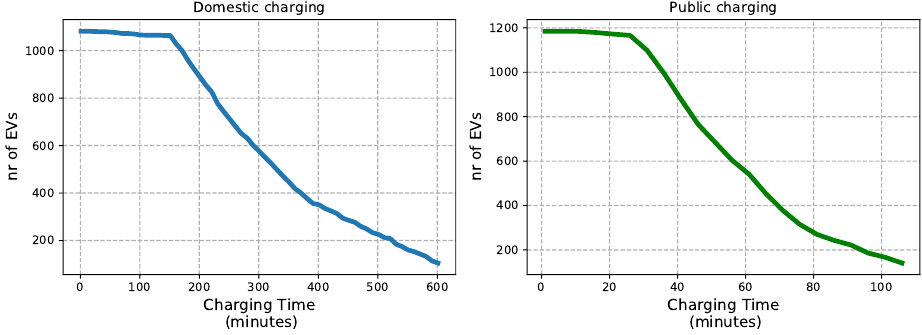
Figure 7. Duration curves of charging time for domestic and public charging in Scenario 1c.